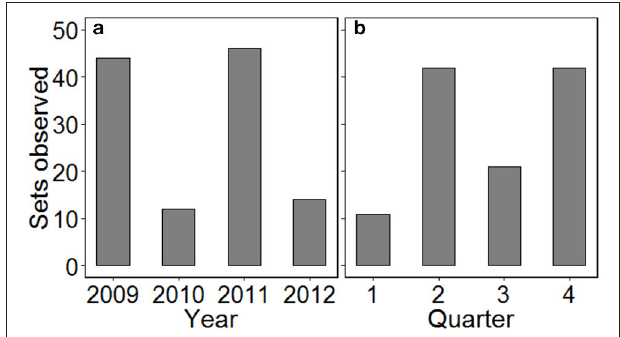
FIGURE 1 | The distribution of gillnet fishing sets observed by (a) year and (b) quarter, from the port of Salaverry in northern Peru, over the study duration. Quarter 1 = January–March, 2 = April–June, 3 = July–September, 4 =